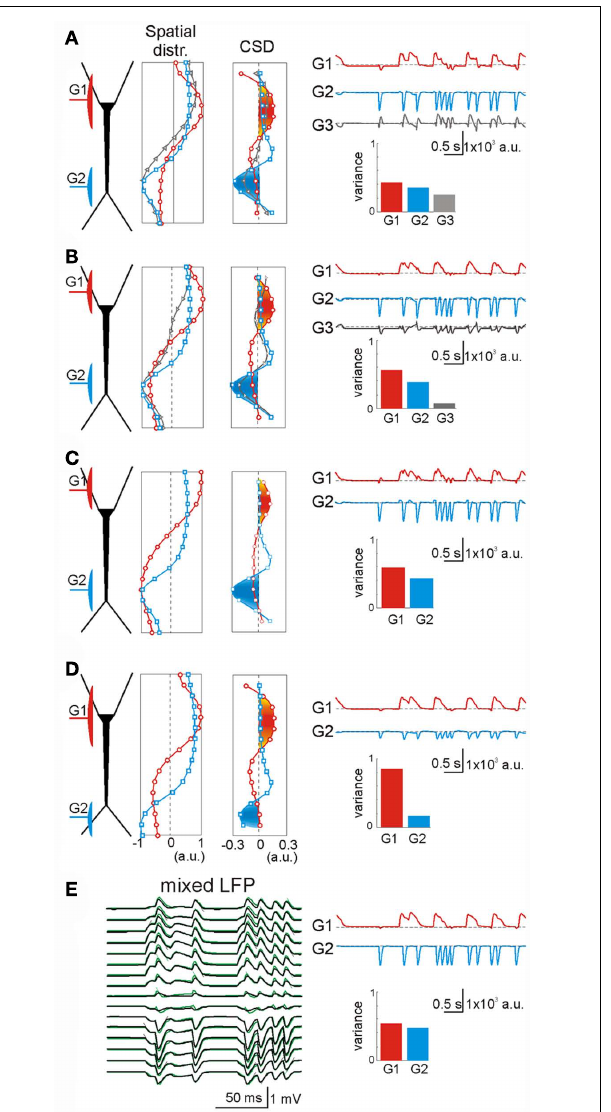
FIGURE 5 | Extra generators may rarely arise due to intracellular interactions of coincident synaptic currents. (A) An inhibitory perisomatic (GABA A ) input (G1, red) was combined with a non-overlapping dendritic excitatory input (G2, blue), both under irregular regimes.The ICA returned three generators, two of them matching the spatial distributions of the original individual inputs.The extra generator (G3, gray) presented an intermediate spatial distribution, and its time course revealed activity when the inputs coincided. (B) A slight shift of the inhibitory input away from the excitatory one reduced the variance of the extra generator down to the 5% border of significance (see Materials and Methods). (C) A further spatial shift of the inhibitory input toward the opposite dendritic tree yielded a perfect separation of the mixed LFPs into the two generators. (D) A distal shift of the excitatory input also led to perfect separation of the contributing LFP-generators [to be compared with (A) ]. (E) To assess the intracellular origin of the extra generator we applied an ICA to mixed LFPs with the same synaptic inputs but obtained by numerical addition of their respective currents (without neurons). In this case (to be compared with A), the separation of the generators was optimal.The slight deviations of neuron-mediated (black) and numerically obtained LFPs (green) quantitatively estimate the mutual interactions of synaptic currents converging on the same